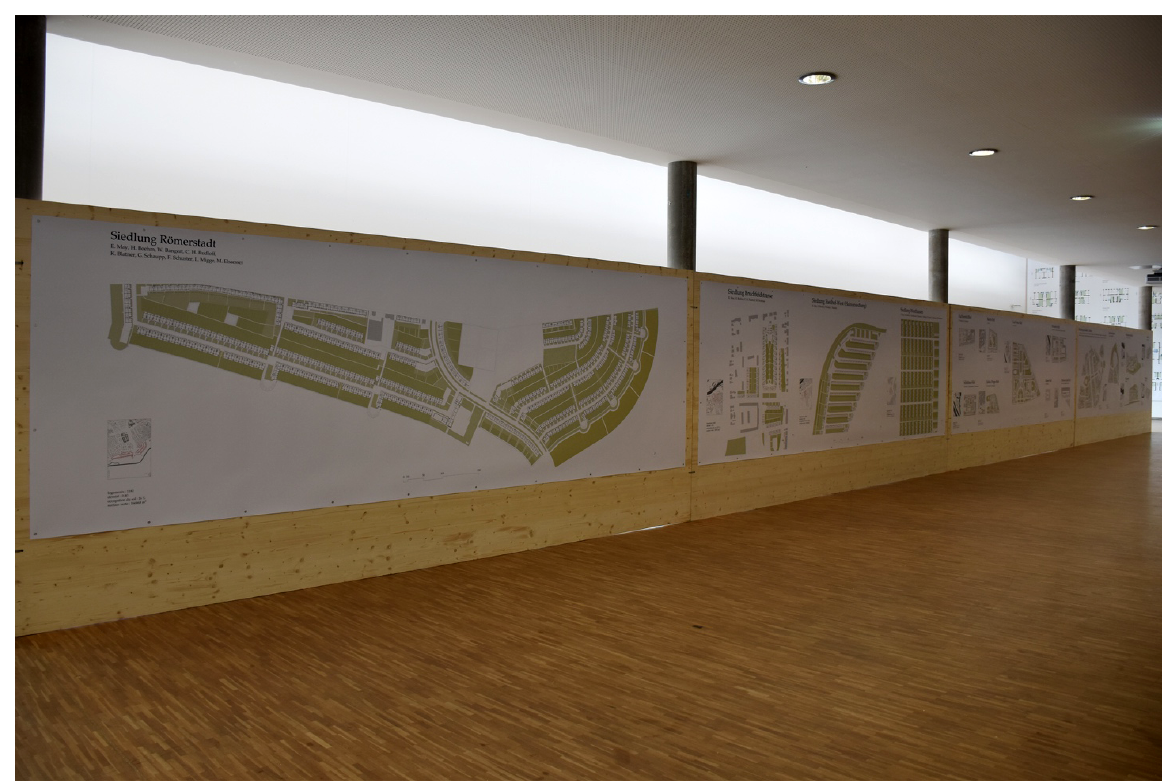
Figure 10. Fourth section: the four panels of typological assemblages. In foreground, there are the four housing estates of Frankfurt. Source: Authors.